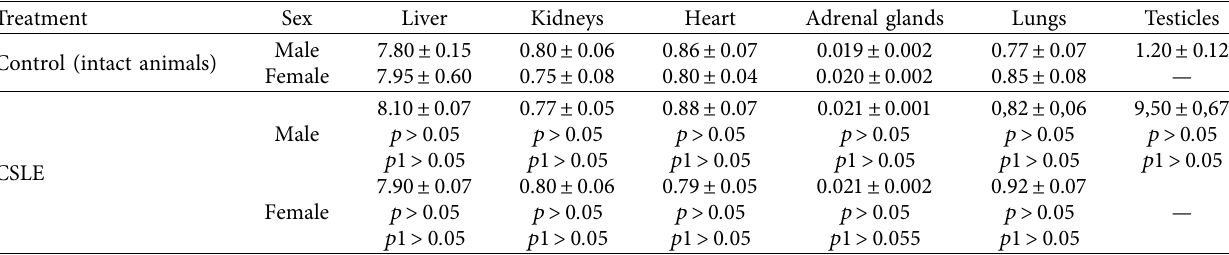
Table 4: Rat internal organ mass (g) following a single injection.